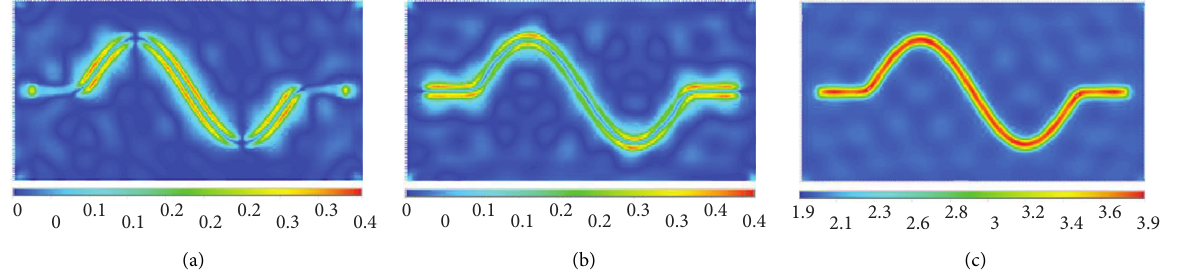
� 500m/s, and NR � 2). Top view displacement cloud view (a) u s